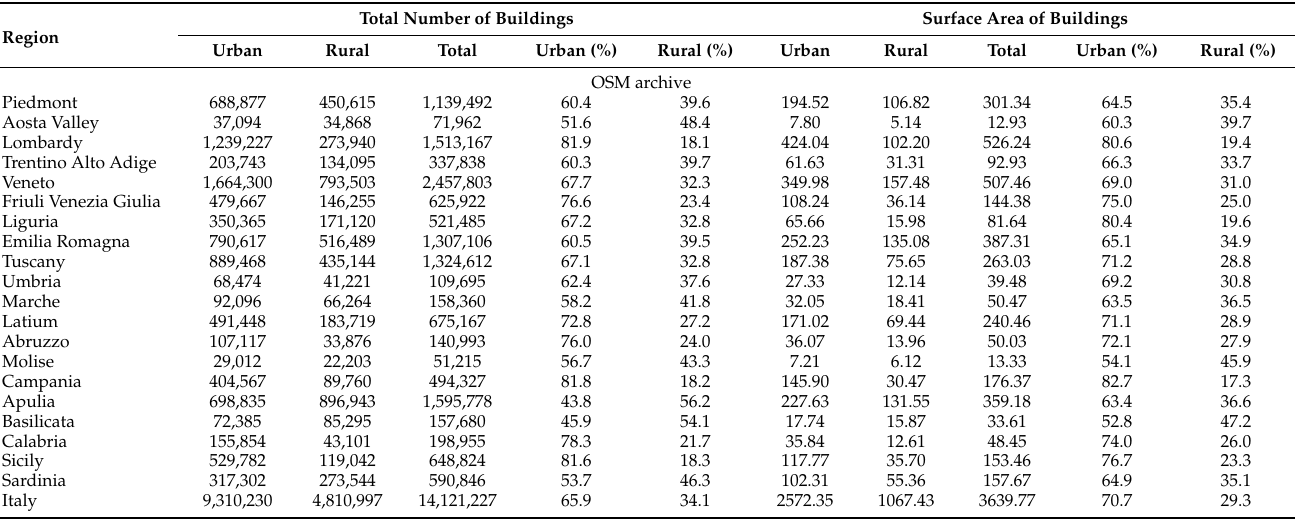
Table 2. Statistical distribution of buildings in OSM and BODA databases for Italy, by urban/rural district and administrative